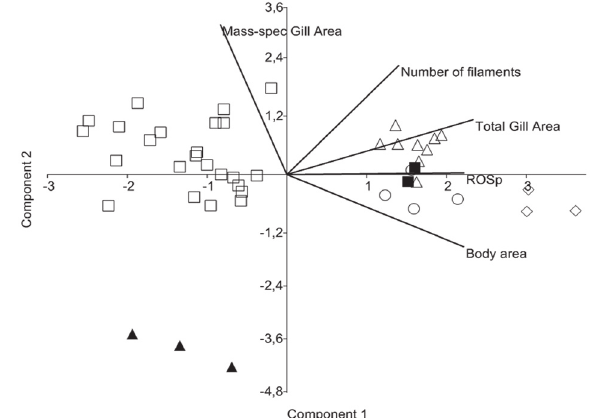
Fig. 6. The two main axes of a principal component analysis based on total gill area, mass-specific gill area, body mass, total length, Anatomical Diffusion Factor and Relative Opening of Spiracule (ROSp) in the different potamotrygonid embryos: black triangle - Plesiotrygon iwamae ; open diamond - Paratrygon aiereba ; circle - Potamotrygon motoro (from Negro River); open triangle - Potamotrygon motoro (from Solimões River); black square - Potamotrygon orbignyi ; open square - Potamotrygon sp. (cururu ray).